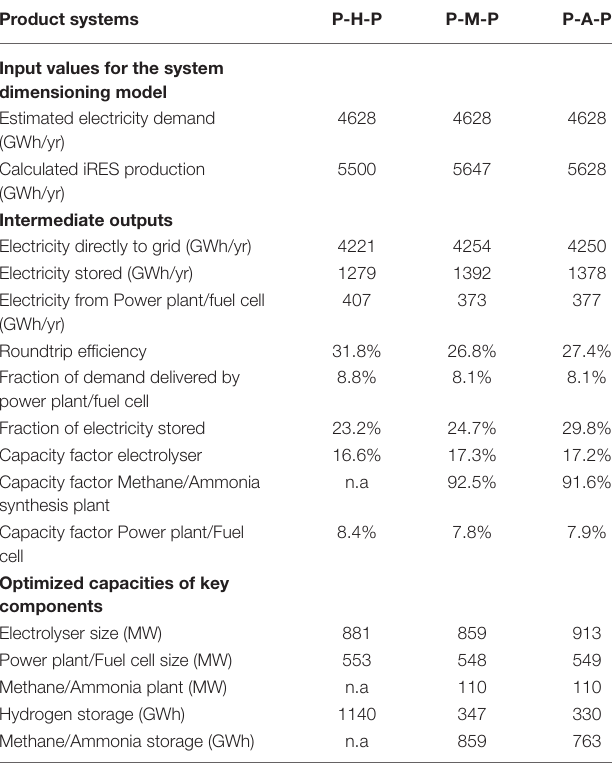
TABLE 3 | Key design parameters as the output from the system dimensioning model. Product